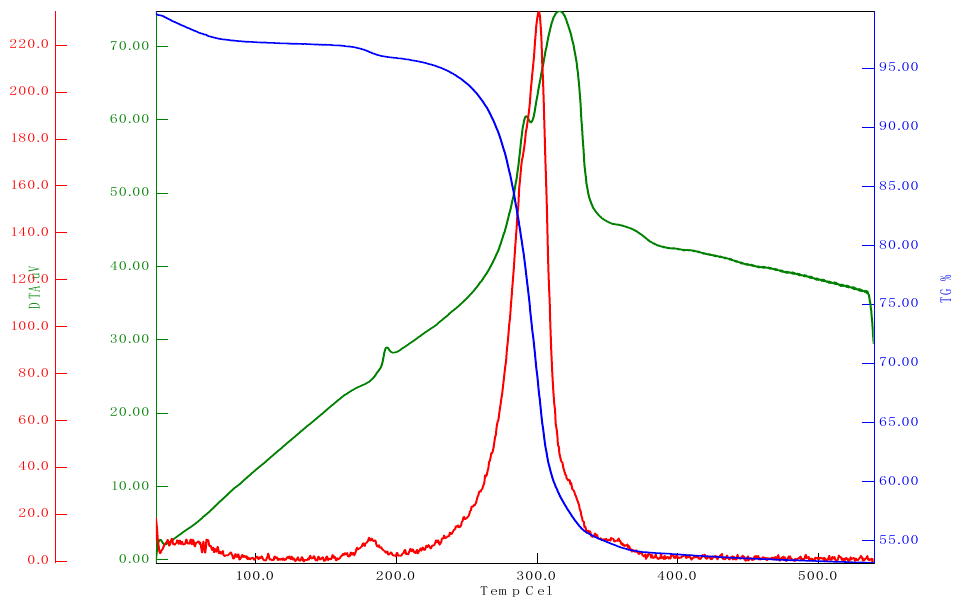
Figure 7. TGA-DTA patterns of the Mn-supported nano-catalyst.